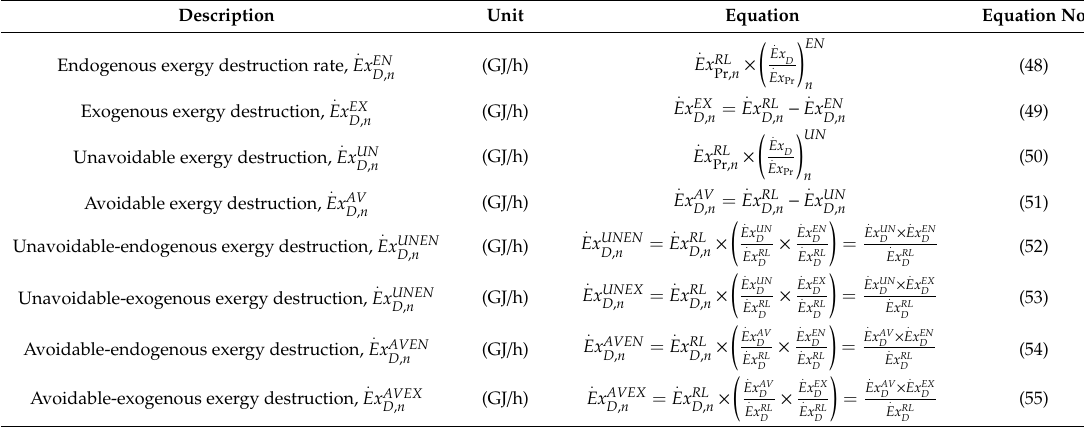
Table 8. The advanced exergy equations of the